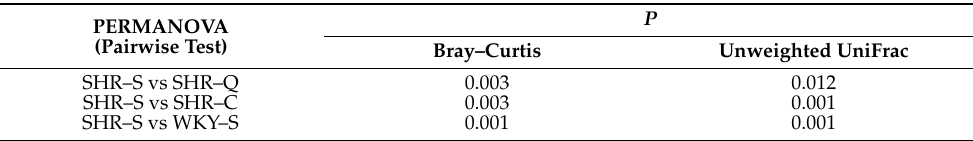
Figure 3. Significant differences in the fecal microbial structure of rats. SHR–S and WKY–S: rats administrated by saline solution for five weeks; SHR–Q and SHR–C: rats administrated by quinoa protein and captopril for five weeks, respectively. ( A ) Alpha diversity of fecal microbiota in different group rats. Significant differences are marked by * p < 0.05 and ** p < 0.01. Beta diversity of the fecal microbiota based on Bray–Curtis ( B ) and Unweighted UniFrac ( C ) distances by NMDS analysis. ( D ) Relative abundance of representative genera in fecal microbiota. P values denote the result of the Kruskal–Wallis comparison; markings above boxplots denote the Dunn’s post hoc result (with Bonferroni correction). Significant differences are marked by * P adj < 0.1; ** P adj < 0.05; *** P adj < 0.01. Table 2. Differences in beta-diversity of the fecal microbiota of rats between two groups were statistically assessed using PERMANOVA based on Bray–Curtis and unweighted UniFrac